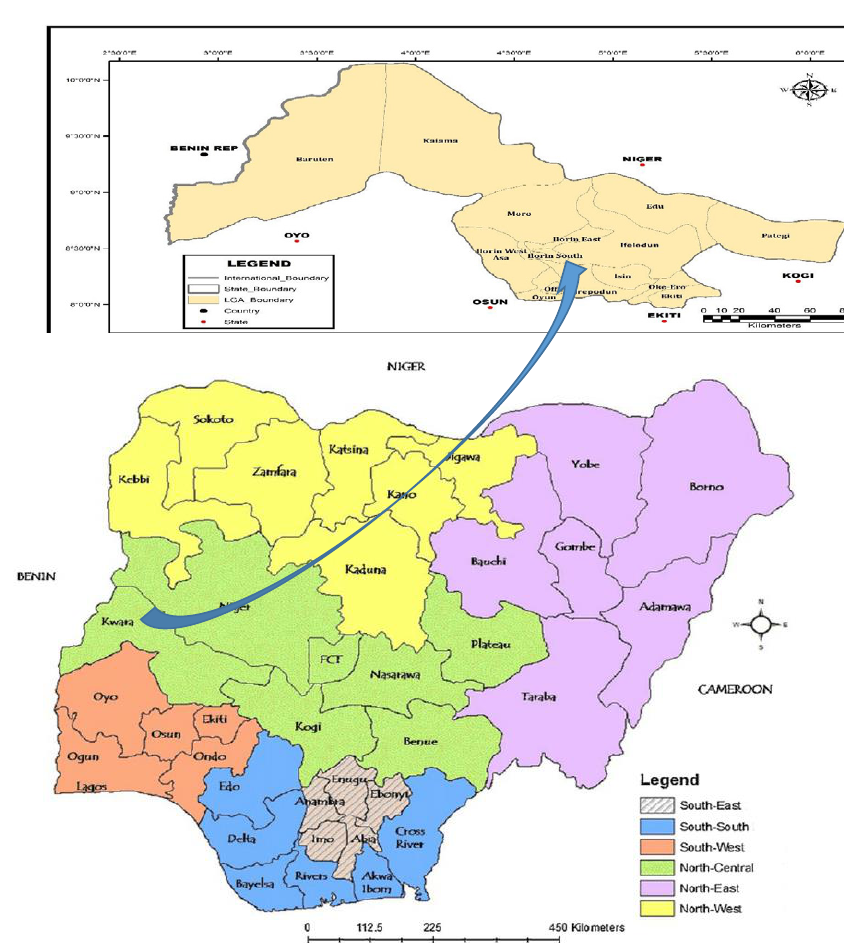
Fig. 3: Geographic location of Ilorin, the capital city of Kwara State, Nigeria (Map Data, 2019)